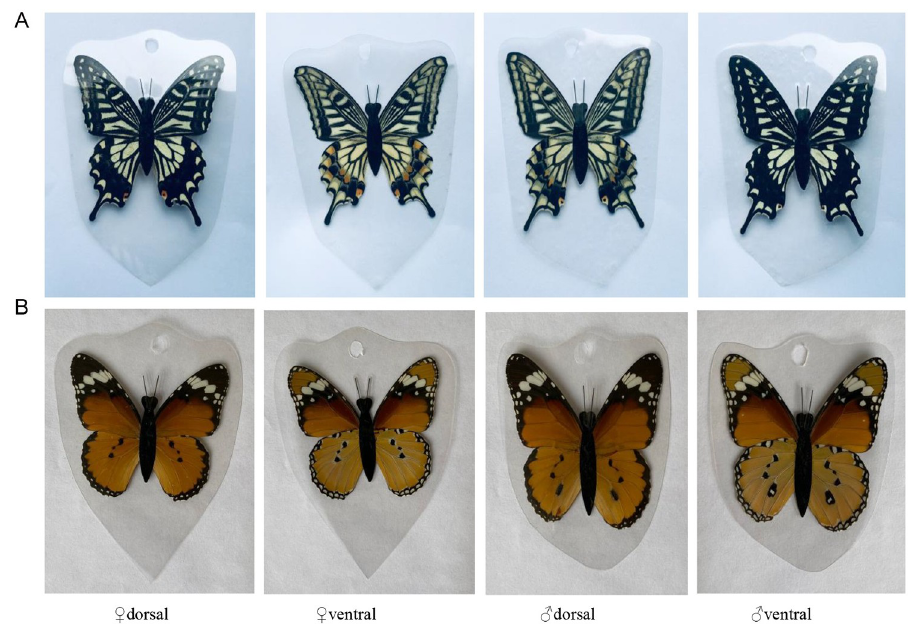
Fig 2. Artificial butterfly model. A. Artificial P . xuthus butterfly model. B. An artificial D . chrysippus butterfly